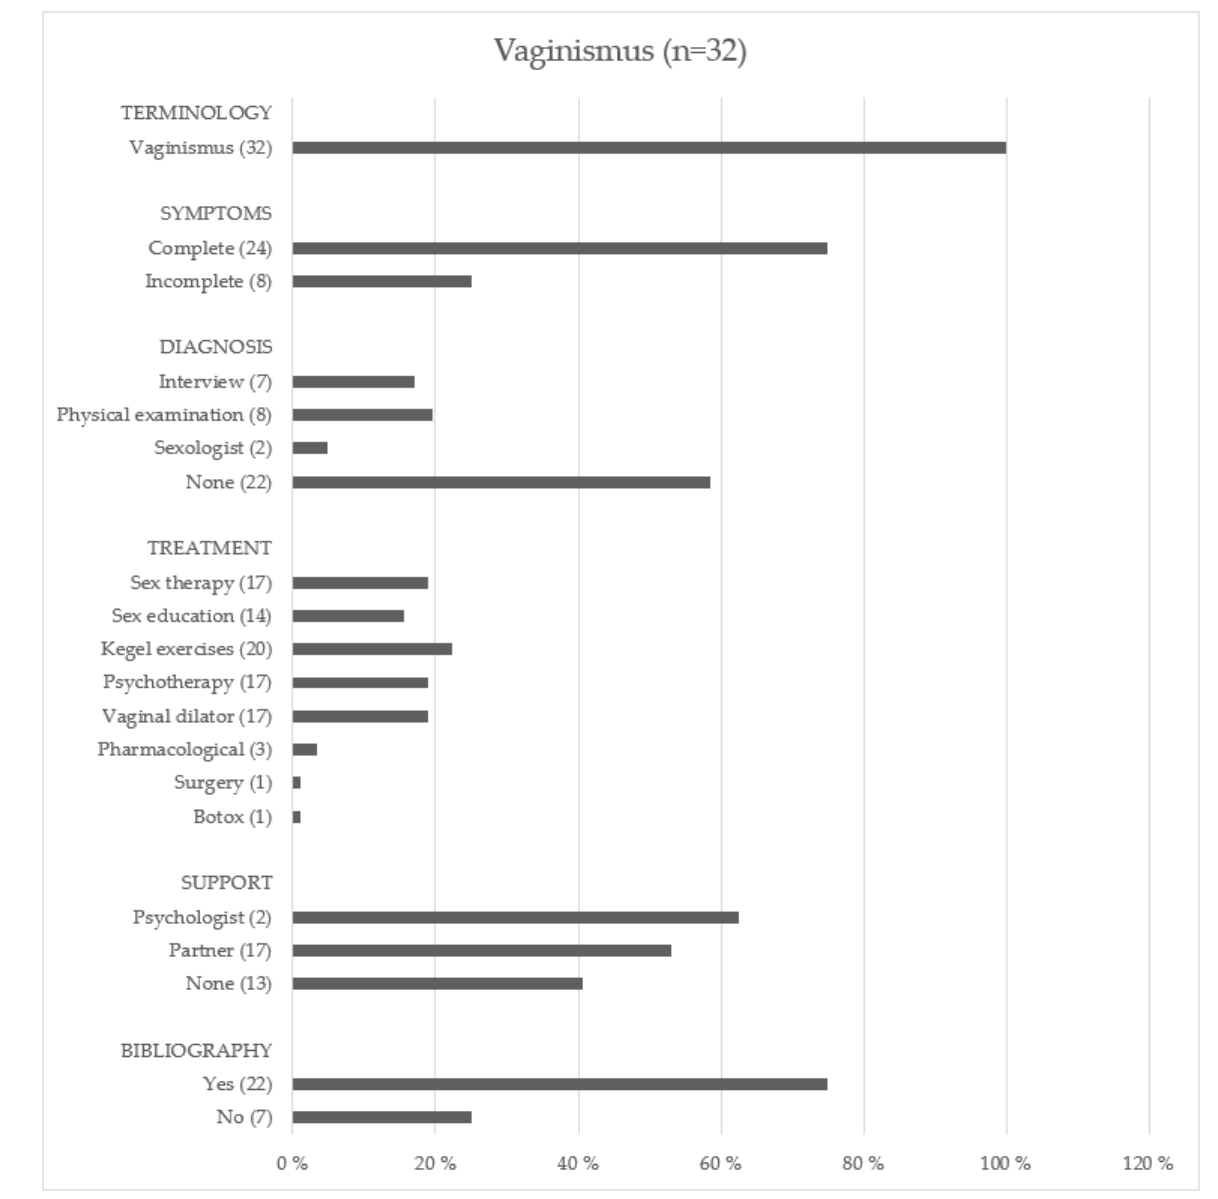
Figure 3. The type of information in websites on vaginismus.